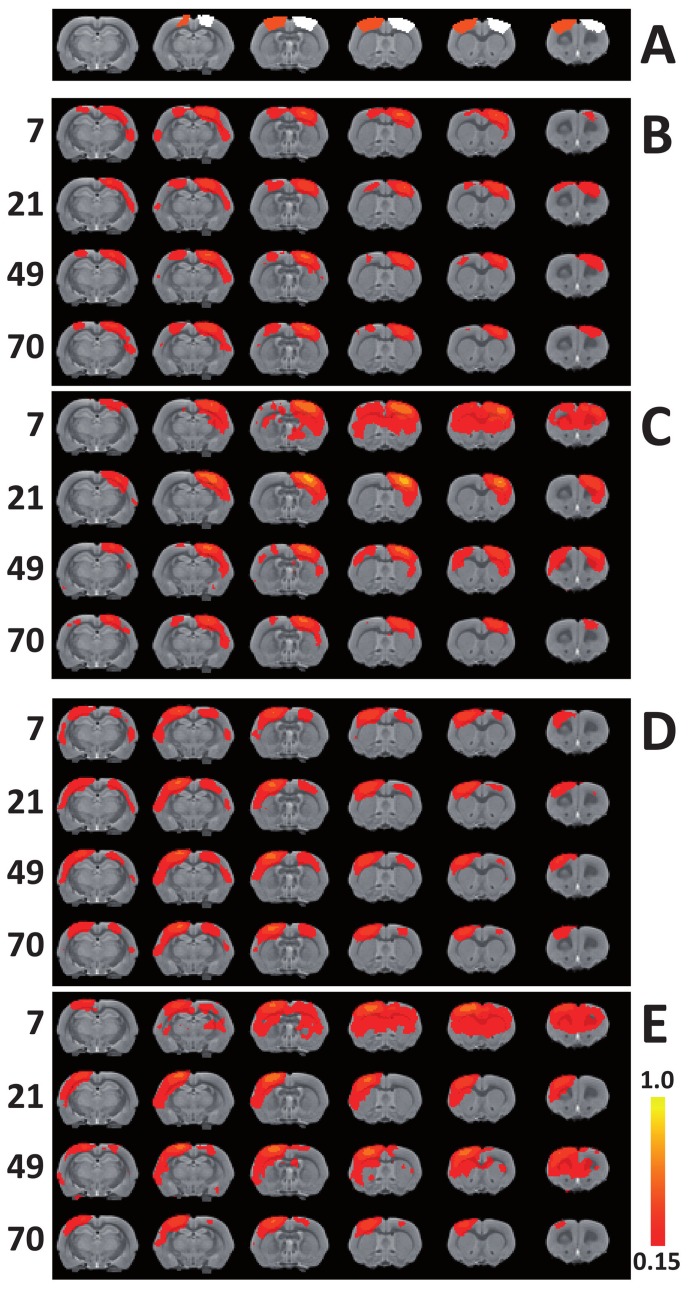
Spatial functional connectivity maps for the bilateral sensorimotor cortices.Functional connectivity maps of right and left sensorimotor cortices with the rest of the brain. Right (ipsilateral) (white) and left (contralateral) sensorimotor cortical ROIs (orange) overlaid on coronal slices from a T2-weighted rat brain template (A). Maps of functional connectivity with right, ipsilateral (B: control group; C: epilepsy group) and left, contralateral sensorimotor cortex (D: control group; E: epilepsy group). Time points (days) are shown on the left. Functional connectivity (z') values range from 0.15 to 1.0. The control group shows strong and consistent functional connectivity between both sensorimotor cortices at all time points. In the epileptic brain, functional connectivity was elevated at day seven, extending into the adjacent secondary somatosensory and medial cingulate cortices, the subcortical caudate putamen, and contralateral homologous areas. At day 21 after epilepsy induction, interhemispheric functional connectivity from both ROIs was clearly reduced, which recovered at the later time points.